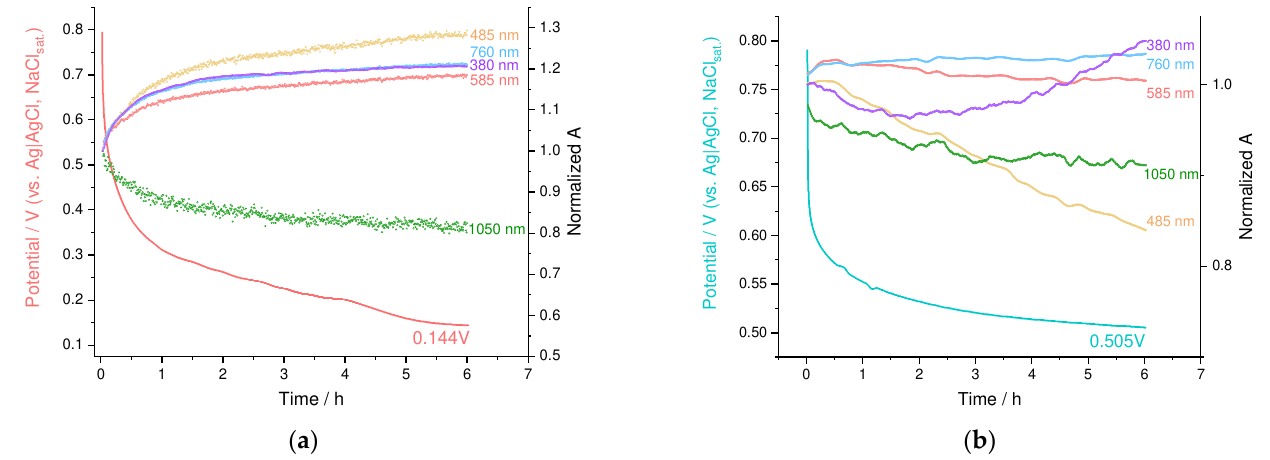
Figure 11. OCP and absorption relaxation plots for ( a ) PEDOT:PSS and ( b ) PEDOT:SPVC films; 0.1 M HClO 4 .